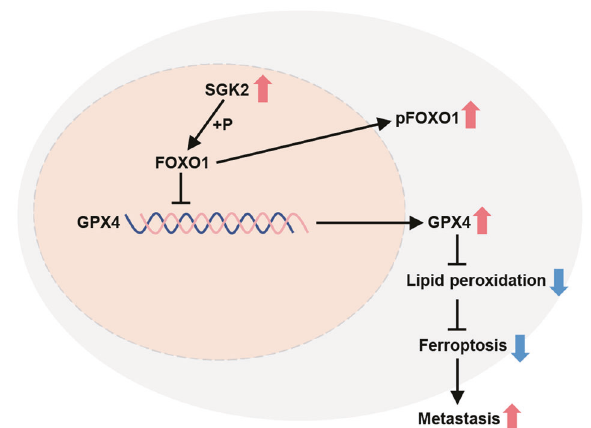
Fig. 7 Schematic illustration of promoting metastasis in PCa cells by inhibition of ferroptosis through SGK2/FOXO1/GPX4 axis. The upregulation of SGK2 increased the nuclear exclusion of FOXO1 via phosphorylating FOXO1 and indirectly upregulated GPX4 expres- sion, which ultimately suppressed ferroptosis and promoted PCa